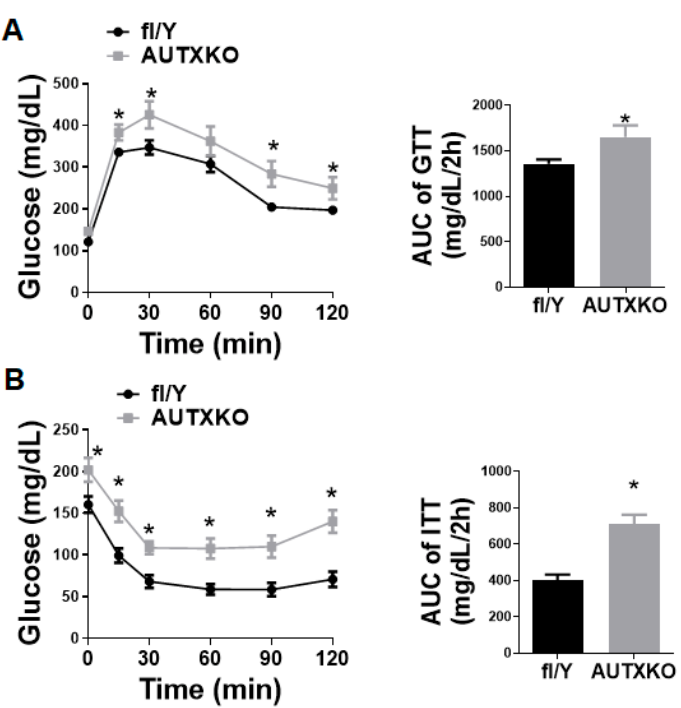
Figure 6. Utx deficiency in adipocytes impairs insulin sensitivity in mice fed HFD. Five-week-old male AUTXKO and fl/Y animals were challenged with an HFD. ( A ) GTT in 16-week-old male AUTXKO and fl/Y animals. ( B ) ITT in 17-week-old male AUTXKO and fl/Y animals. All data are presented as mean ± S.E.M.; n = 11/group; * p < 0.05 vs. fl/Y .